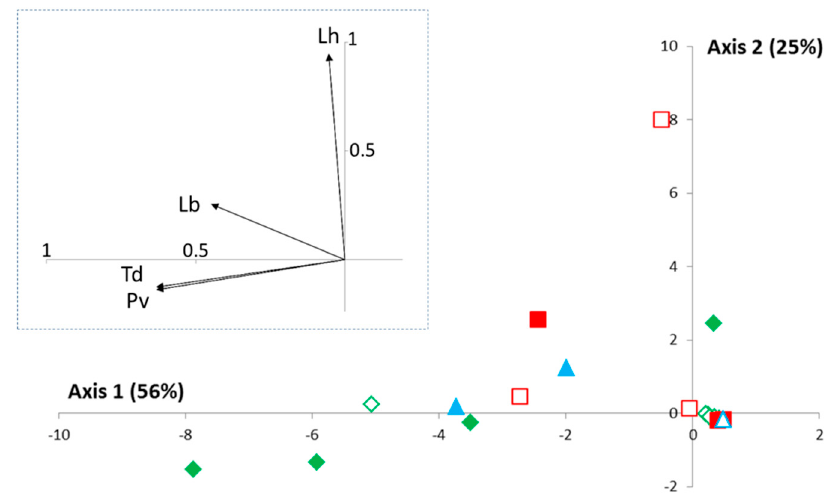
Figure 4. Principal components analysis (PCA) on parasitoids collected in Condition 1 (fruits alone) of the “Frozen Fruits” method. The PCA analysis was performed from the distribution of the different parasitoid species in each of the “location/replicas x date” combinations. The associated inertia is provided for each axis. The code for the “location” is as follows (see also Table 1): (i) Green = low elevation—cultivated area (plain signs = BAR; empty signs = STJ); (ii) Red = low elevation—natural habitat (plain signs = TIG; empty signs = BIO); (iii) Blue = mountainous backland (plain signs = CIP; empty signs = FER). Contrary to Figure 1, the temporal dynamics were not explicitly shown here (see Results). The correlations between each PCA axis and each parasitoid species are presented in the grey square (rescaled and shifted for a better readability). Lb, Lh, Pv, and Td correspond to Leptopilina boulardi , L. heterotoma , Pachycrepoideus vindemmiae, and Trichopria cf drosophilae , respectively.